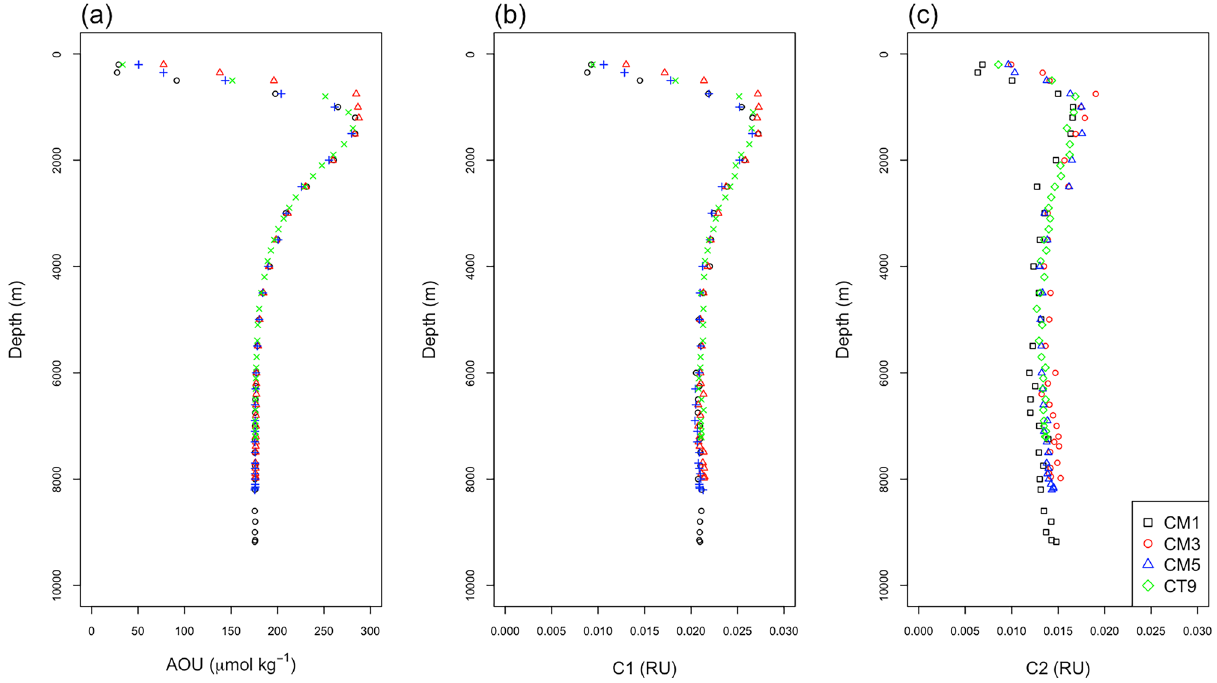
Figure 2. Vertical distributions of ( a ) AOU (μmol kg −1 ), humic-like FDOM ( b ) C1 (RU), and ( c ) C2 (RU). Black squares represent CM1, red circles represent CM3, blue triangles represent CM5, and green diamonds represent